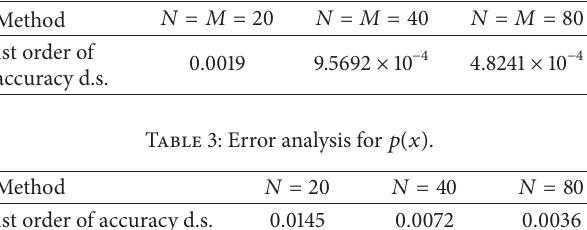
Table 2: Error analysis for the exact solution 𝑢(𝑡,𝑥) . Method